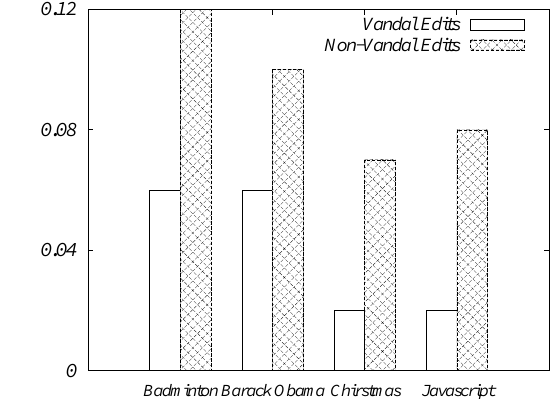
Figure 4. WCoP Values for Vandal and Non-vandal